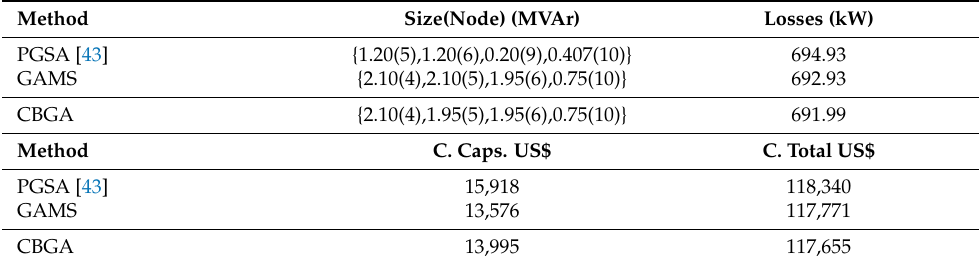
Table 8. Capacitors location in the 10-node test